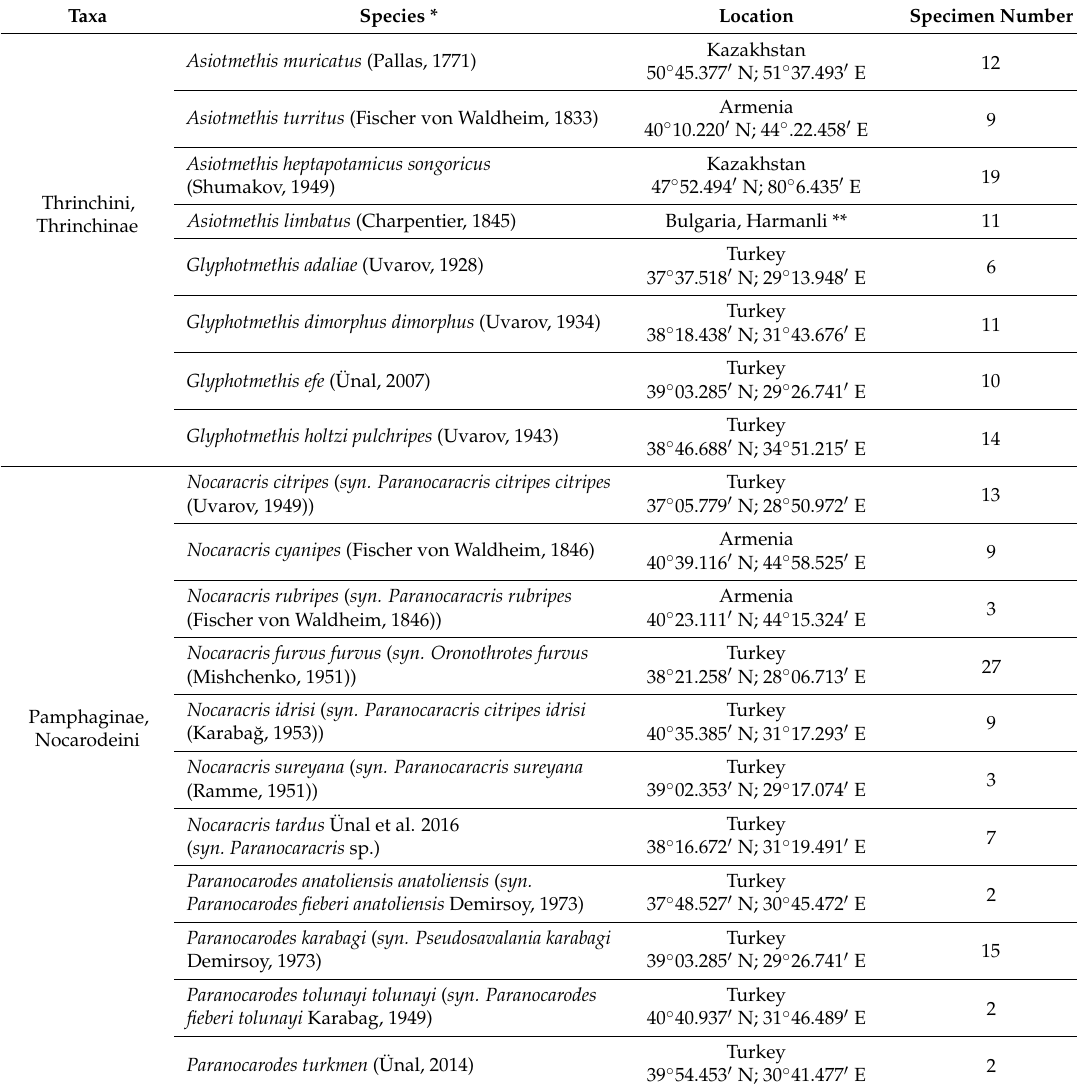
Table 1. List of species studied and collection